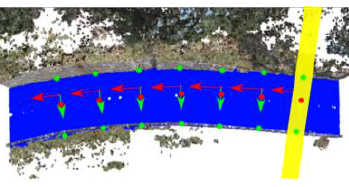
Figure 9. Roadway limits and alignment. Search window in yellow. The green points are the roadway limits. The red points are the alignment.